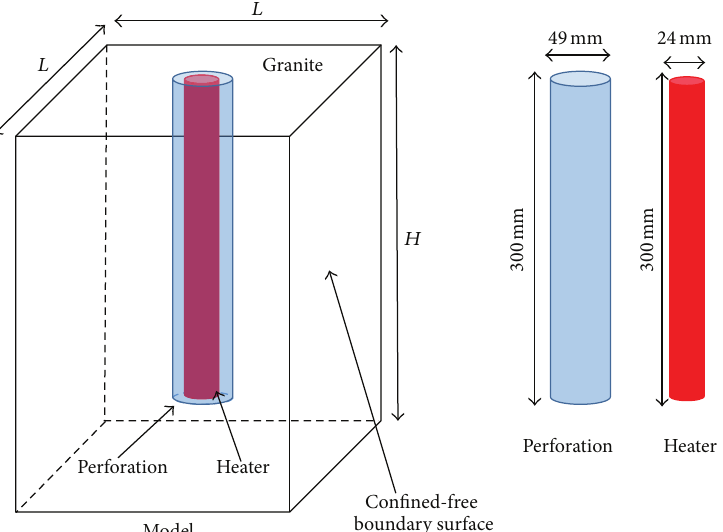
Figure 4: Details of experimental test